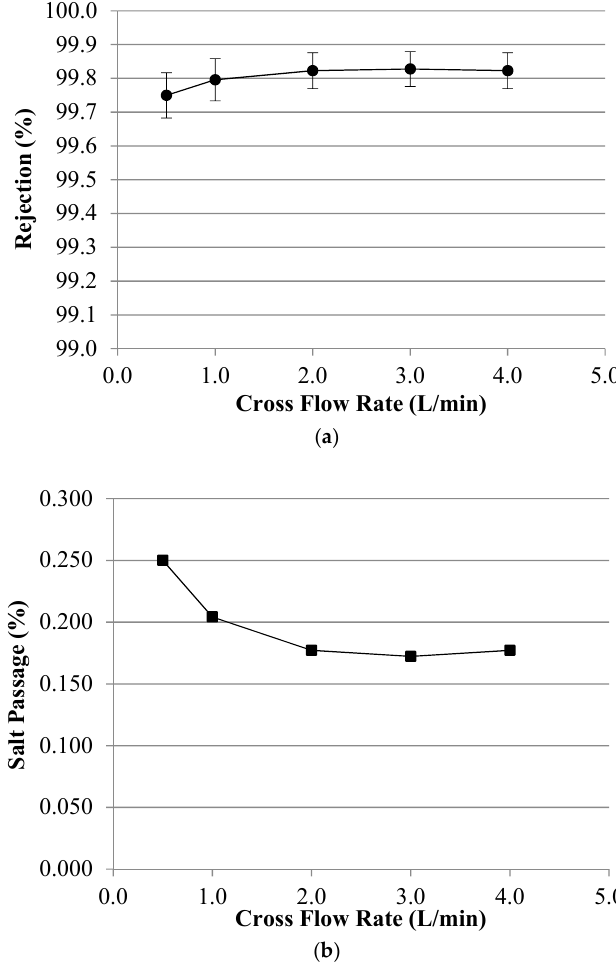
Figure A1. ( a ) Graph of rejection as a function of the cross flow rate (Operating Conditions: 2000 mg/L MgSO 4 , pH 7, 25 °C, and 10 bar). ( b ) Graph of salt passage as a function of the cross flow rate (Operating Conditions: 2000 mg/L MgSO4, pH 7, 25 °C, and 10 bar).